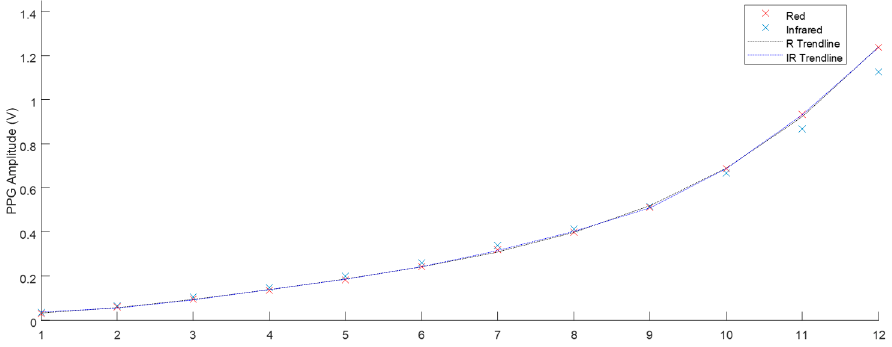
Figure 10. The mean PPG amplitude of three-minute samples with 6 L·min − 1 flow and heart rates from 40–120 BPM (all SD < 0.003).